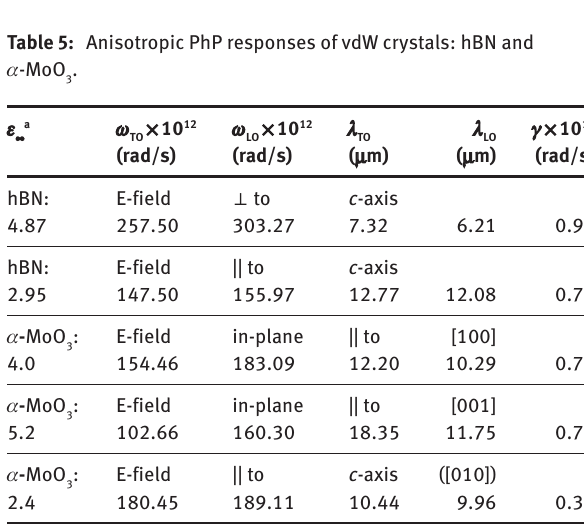
Figure 7: Structure and IR active phonon modes of hBN. (A) The hBN vdW crystal (atomic spacings taken from [126]). (B) [(C)] The IR-active in-plane ( E